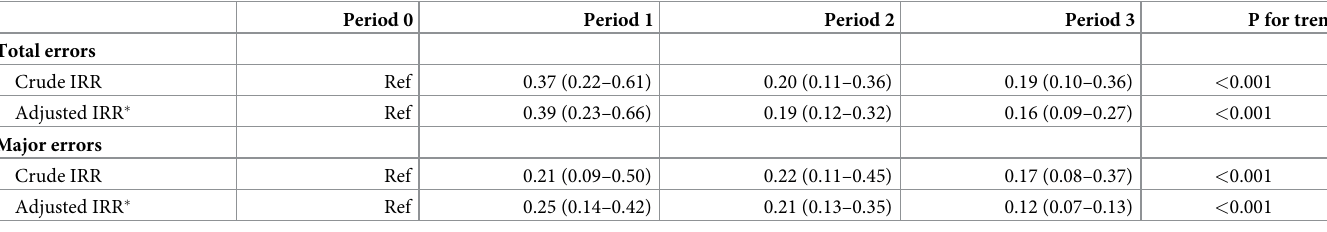
Table 2. Association between study periods and error incidence